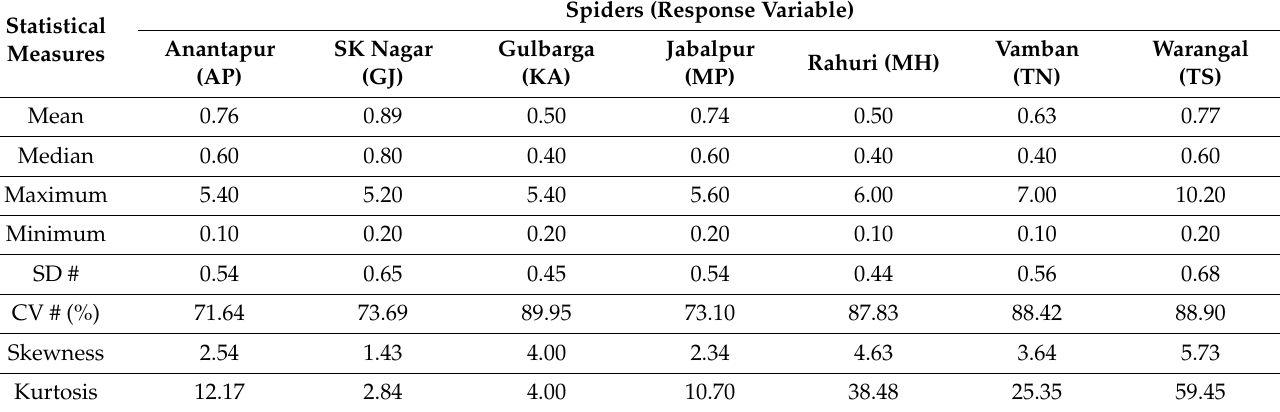
Table 2. Descriptive statistics of response variable.